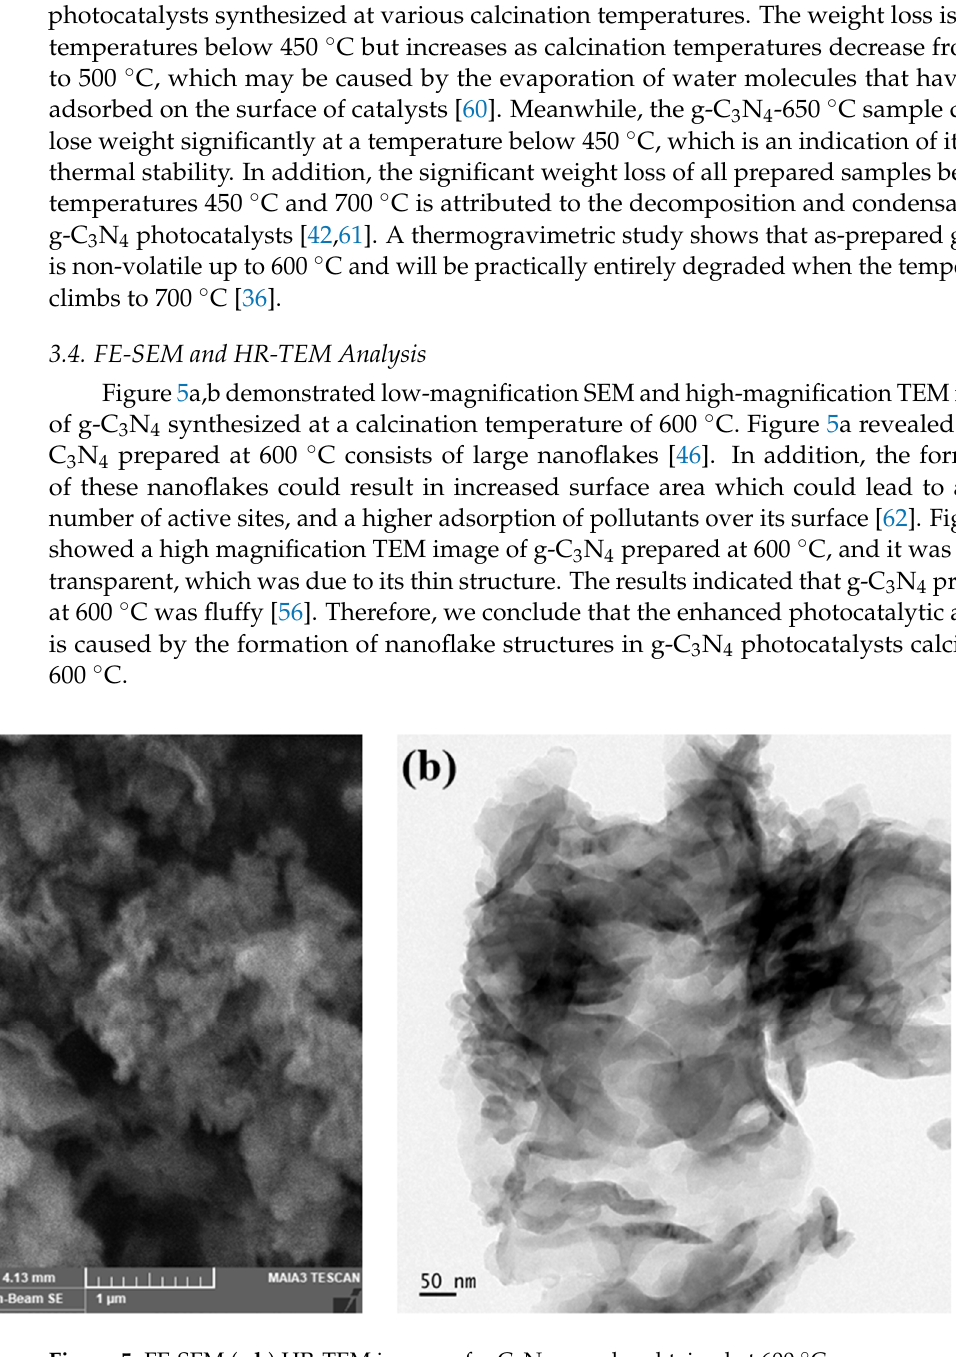
Figure 5. FE-SEM ( a , b ) HR-TEM images of g-C 3 N 4 samples obtained at 600